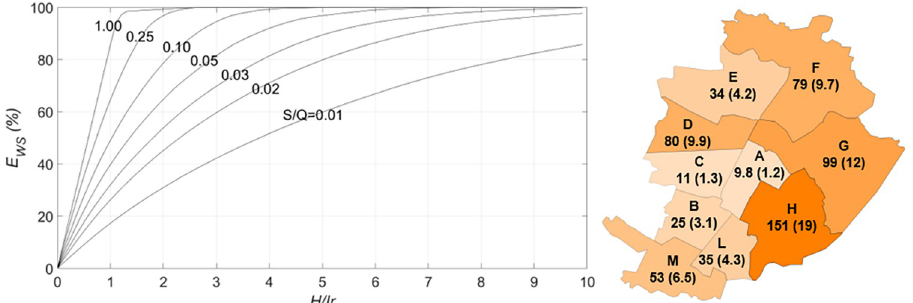
Fig 8. Irrigation. Left: dimensionless graph used for tank design purposes. Right: average water savings in one year (10 3 m 3 ) and the required capacity of the tanks, in brackets (10 3 m 3